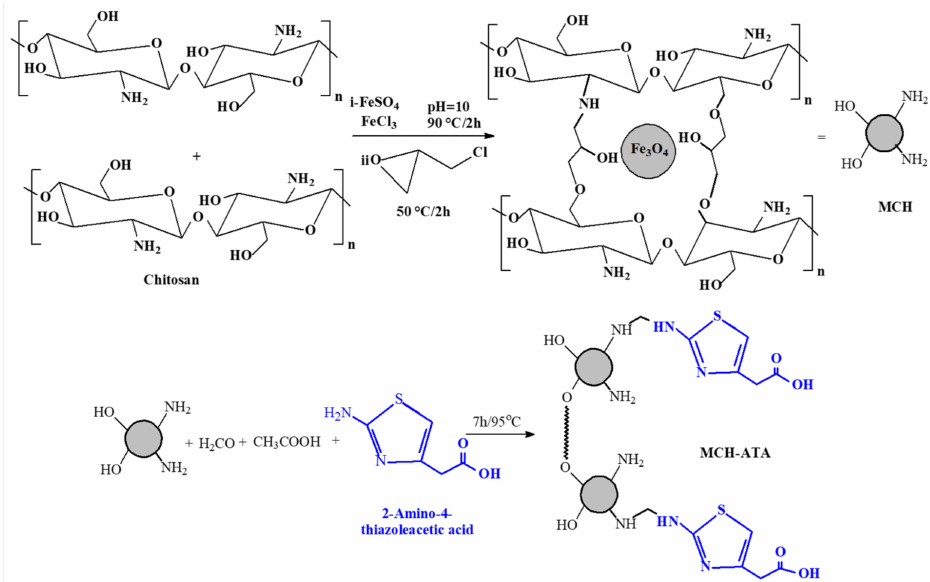
Scheme 1. Synthetic route of thiazole derivative nanoparticles.